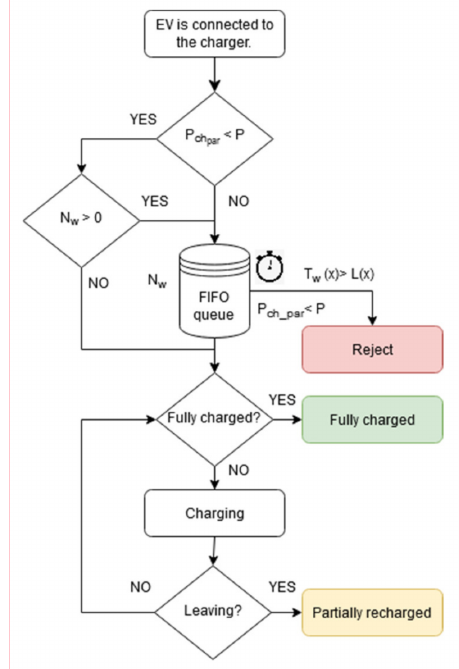
Figure 2. Nonresident charging